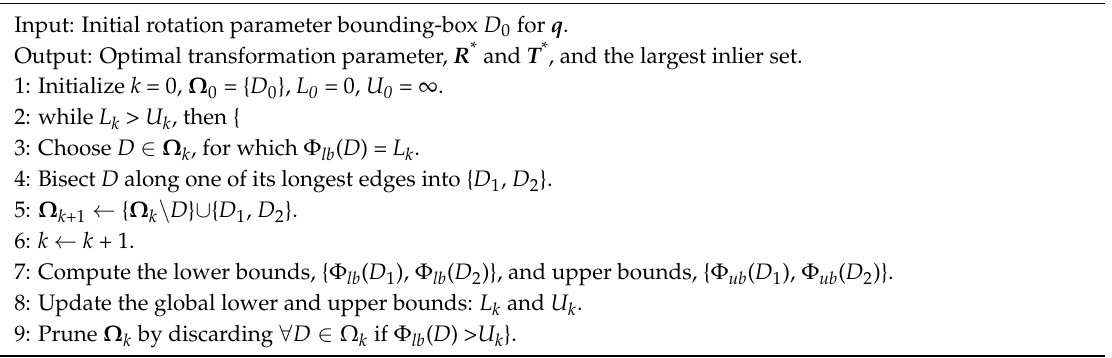
Algorithm 1 MILP-based branch-and-bound method for 3D registration with